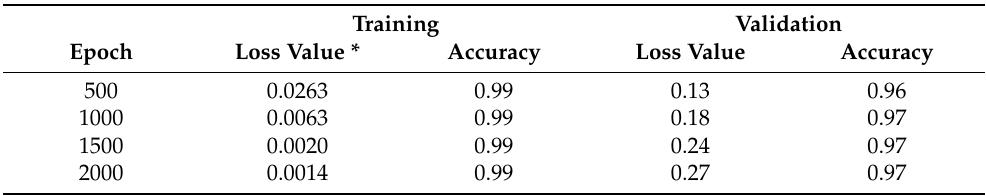
Table 1. Summary of U-Net performance of each